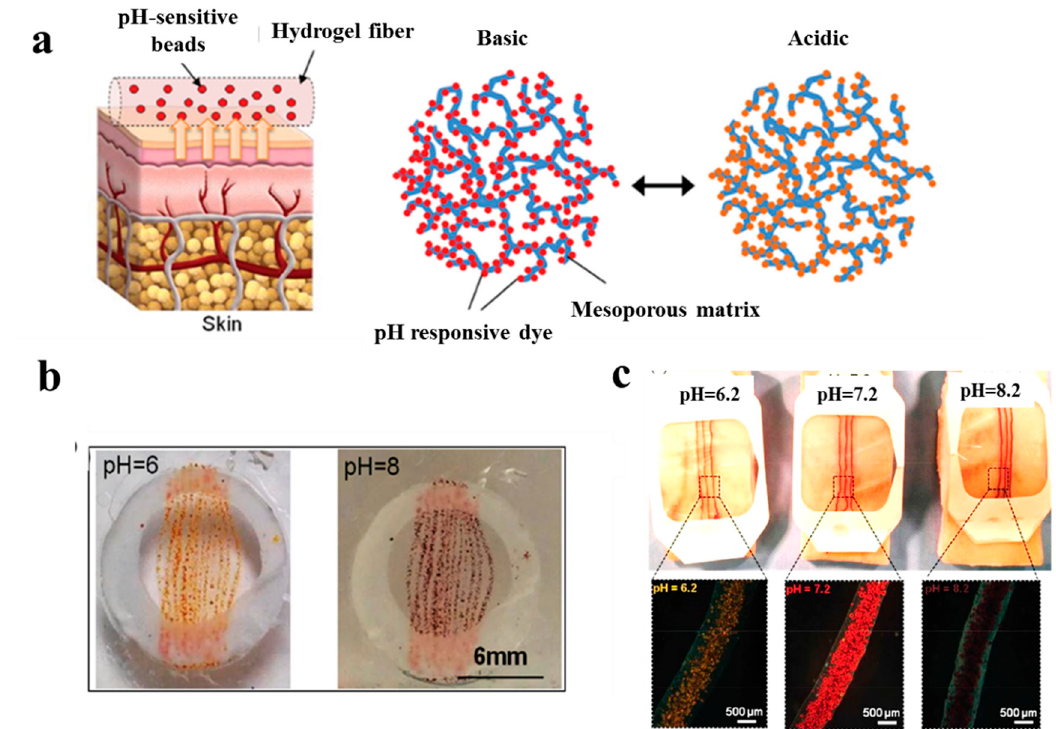
Figure 6. ( a ) Schematic illustrating the application of a pH sensor-based hydrogel containing pH-sensitive beads on skin and the color changes in basic and acidic environment; ( b ) macroscopic pictures of hydrogel fiber-based patches with pH-sensitive beads under acidic and basic conditions; ( c ) images representing color changes of pH-sensitive dressings placed on pig skin when sprayed with solutions of different pH values [115] .